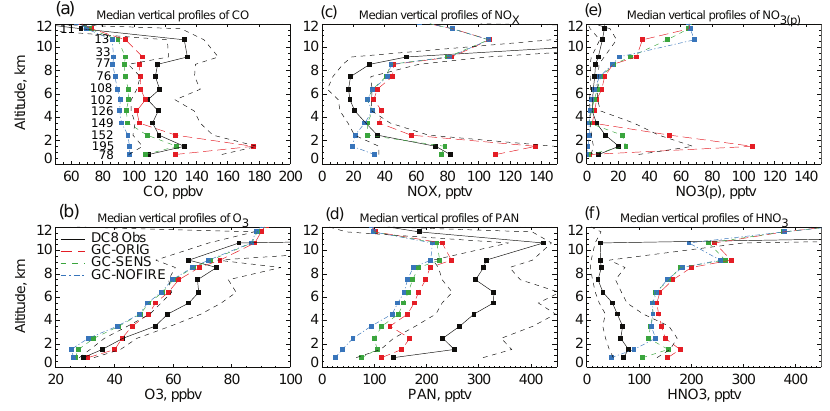
Fig. 6. Median vertical profiles of (a) CO, (b) ozone, (c) NO x , (d) PAN, (e) fine aerosol nitrate (NO 3 ( p ) ) and (f) HNO 3 ( g ) during ARCTAS- B. The solid black line is the DC8 observations (the dashed black lines are the 25th and 75th percentiles of the observations), the red line is the results of the original GEOS-Chem model run (GC-ORIG), the green line is from the model emissions sensitivity study (GC-SENS) and the blue line is when extratropical fire emissions are set to 0 (GC-NOFIRE). The numbers in the profile of CO represent the number of observations at each altitude